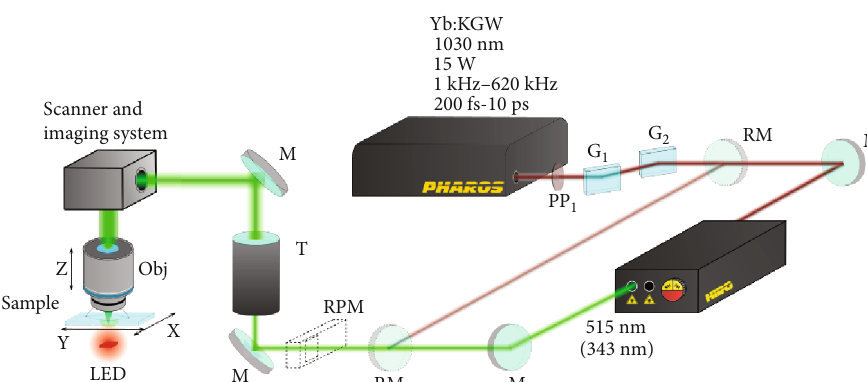
: phase plate; G and 1 1